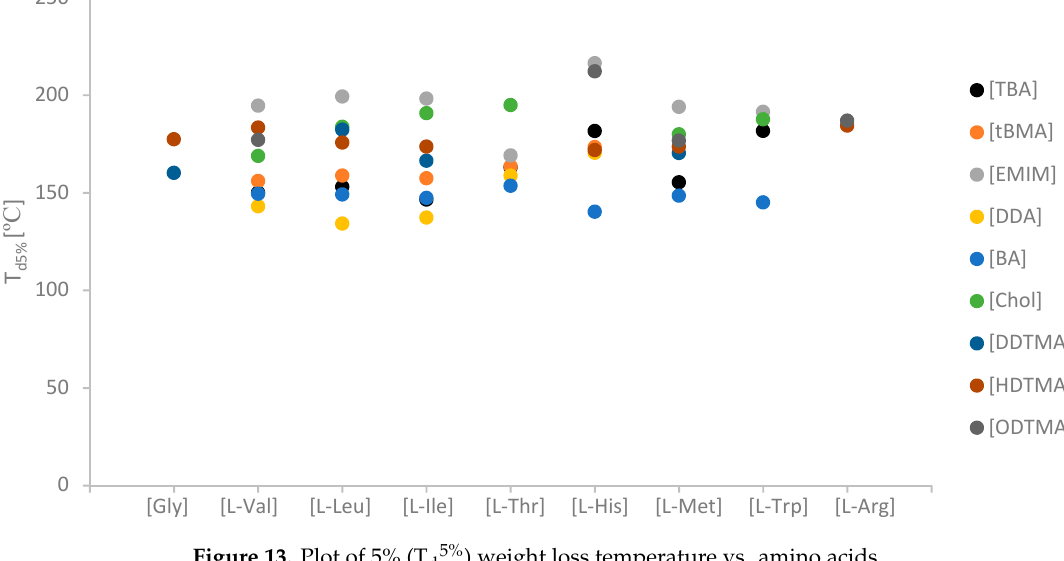
Figure 13. Plot of 5% (T d5% ) weight loss temperature vs. amino acids.